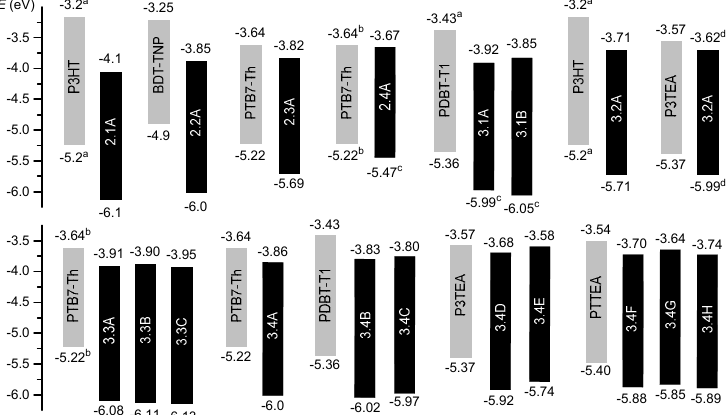
Figure 6. Summary of energy level diagrams of the donor and PDI materials used in the OPV devices. ( a ) The FMO energy levels were cited in ref 90. ( b ) The FMO data were cited in ref 78. ( c ) The HOMO energy levels were estimated by comparison of the LUMO energy levels and optical gaps of the materials, which were provided in the original reports. ( d ) The original data provided in the original reports are cited as the FMO energy levels, although there is substantial disagreement of the values for the material with those given in the earlier reports. Adapted from refs cited in Table